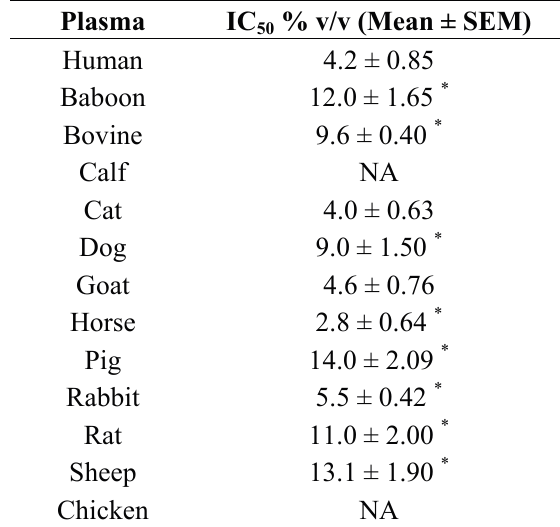
Table 2. Comparative effects of plasma obtained from different species on AA induced human platelet aggregation.